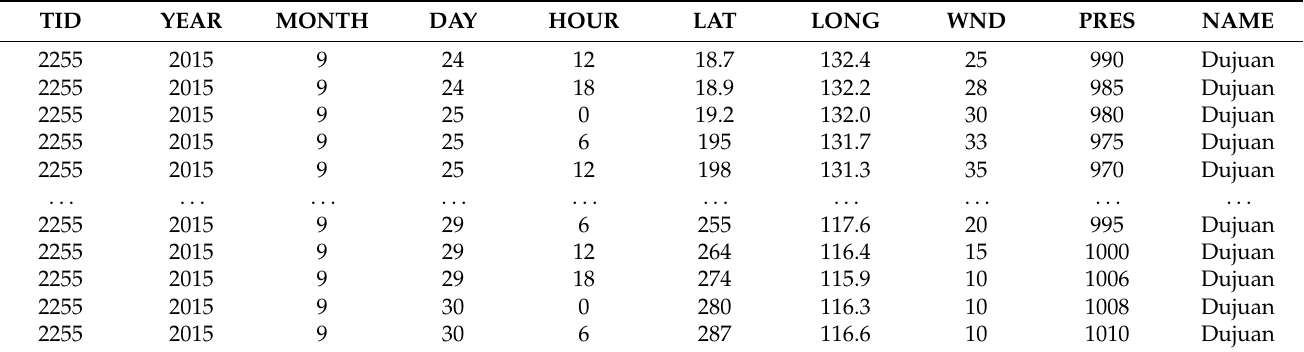
Table 4. Data representation of tropical cyclone Cuckoo.